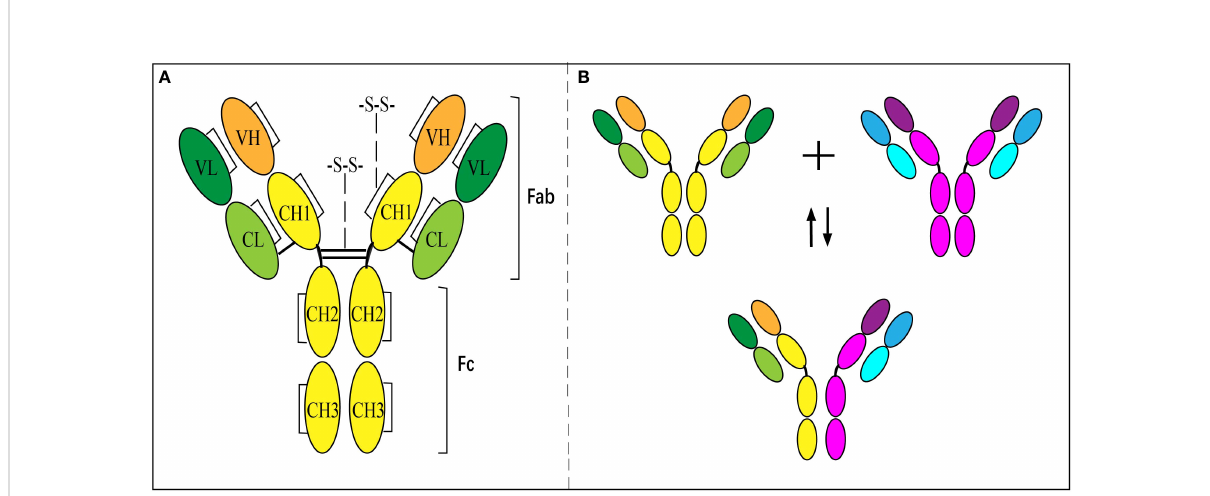
FIGURE 1 Structure of IgG4 antibody and Fab-arm exchange. (A) Inter- and intra-chain disul fi de bonds give structure to IgG4. (B) Antibodies separate into ‘ half-molecules ’ , each comprising one heavy and one light chain. Half-molecules recombine to form bi-speci fi c